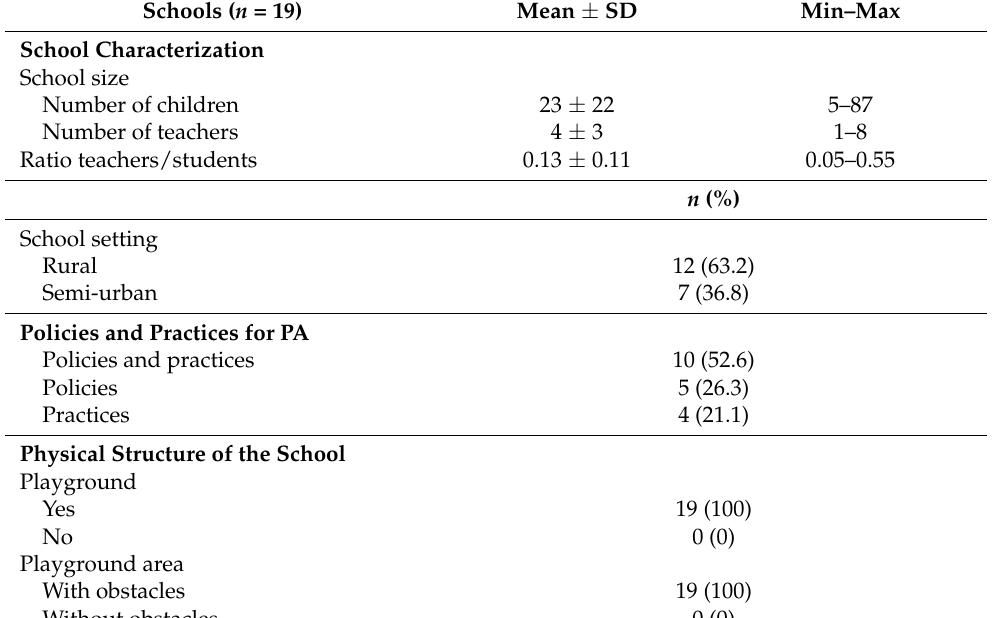
Table 3. Descriptive statistics of the school